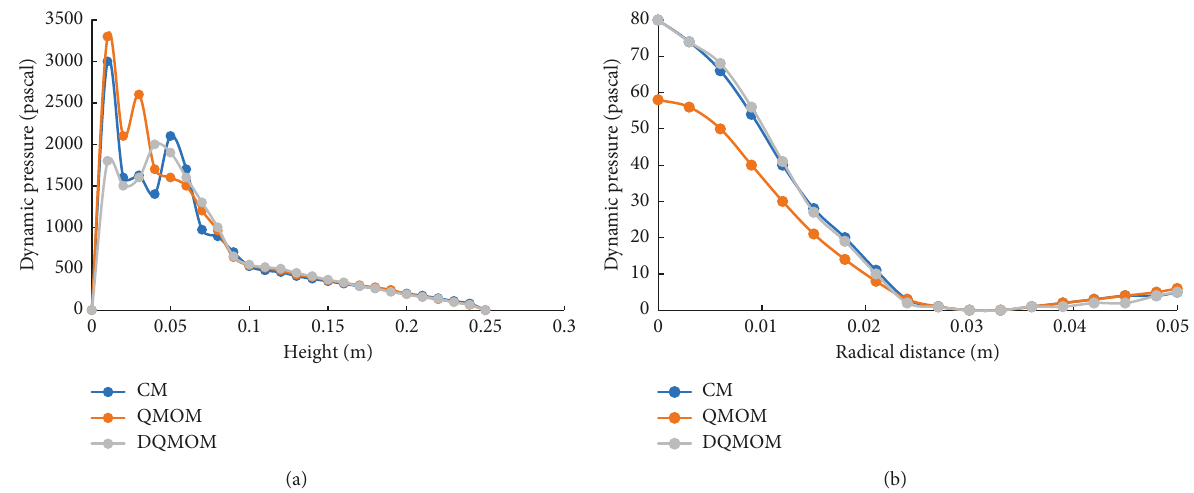
Figure 9: The droplets dynamic pressure along (a) the height and (b) the radical distance h � 0.2m in the extractor.